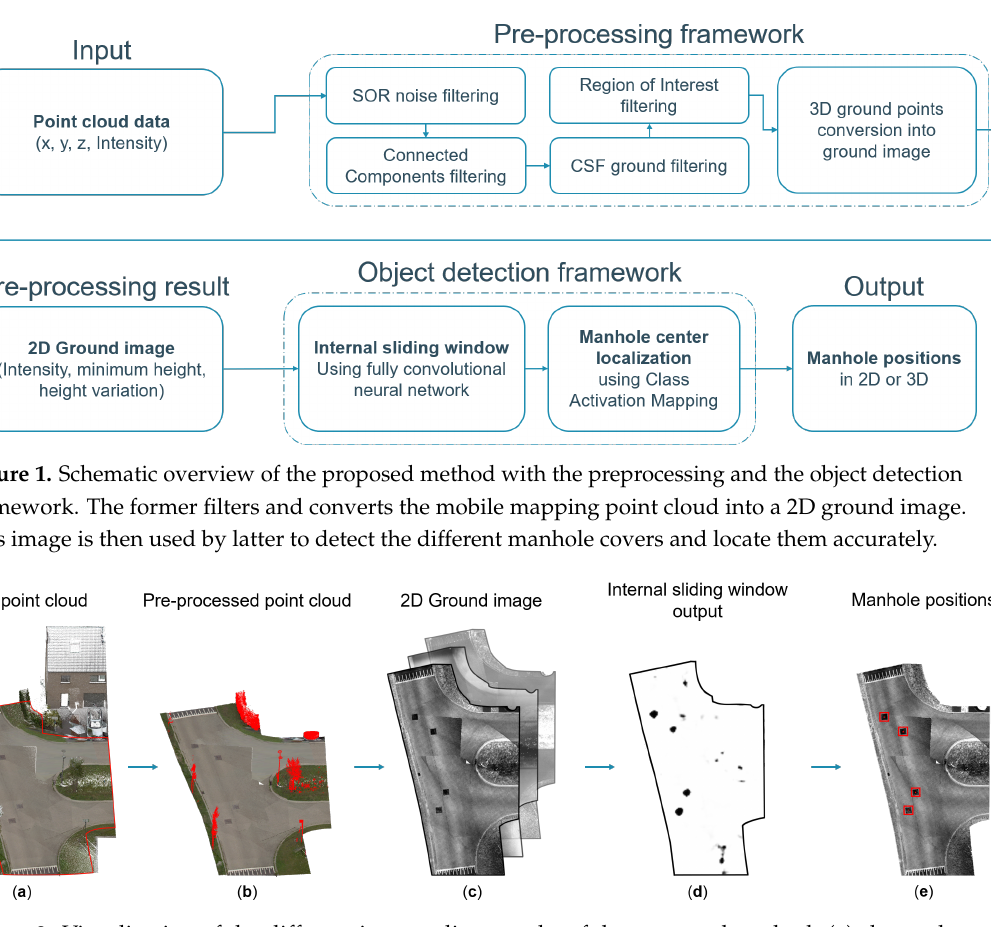
Figure 2. Visualization of the different intermediate results of the proposed method: ( a ) shows the input point cloud with the region of interest indicated by a red outline. ( b ) visualizes the filtered point cloud after preprocessing with the off-ground points colored in red. ( c ) shows the 2D ground image with the intensity, minimum height and height variance channels rasterized from the ground points. ( d ) displays the spatial classification output from the fully convolutional neural network with the colors black and white corresponding to a high or low manhole classification score, respectively. ( e ) visualizes the predicted manhole cover positions in red generated from the spatial classification